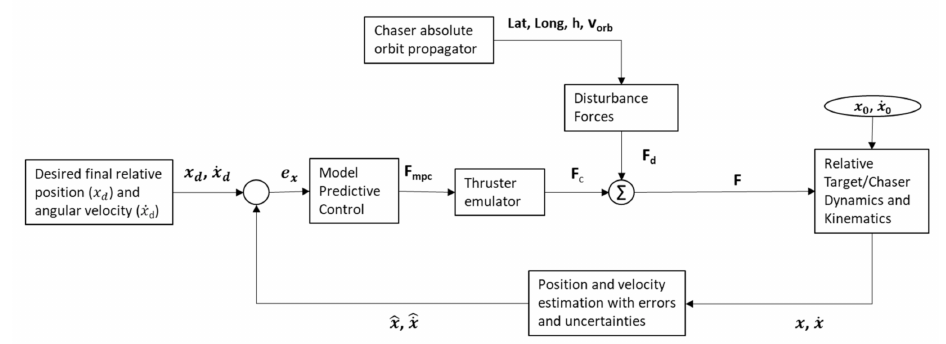
Figure 3. Simulation architecture.